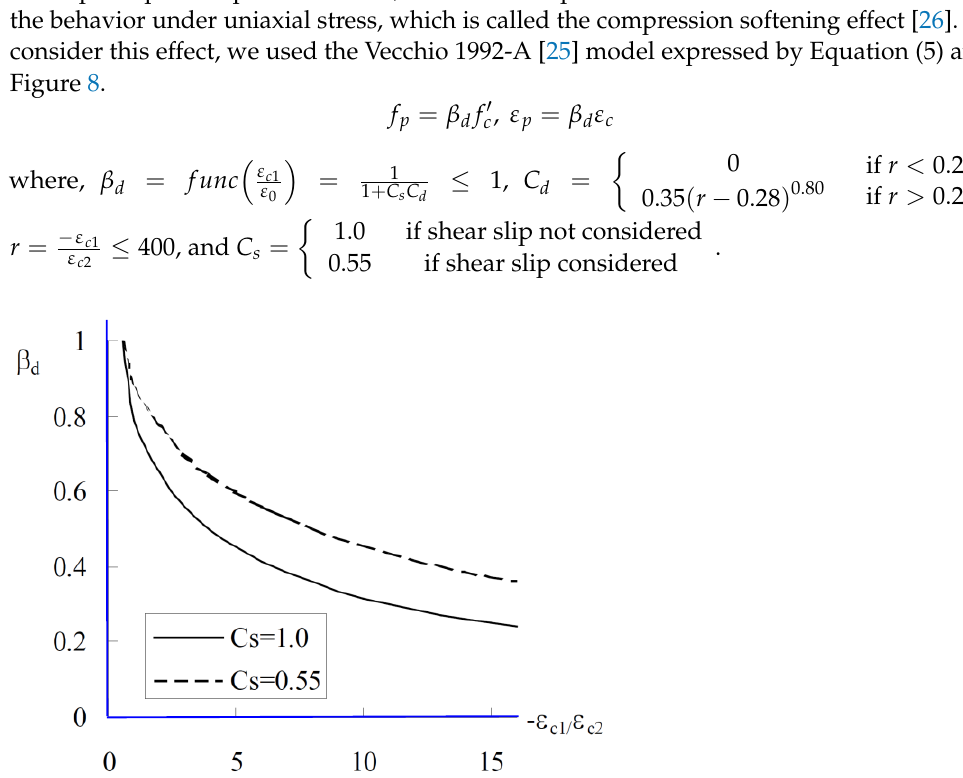
Figure 8. A compression softening model.